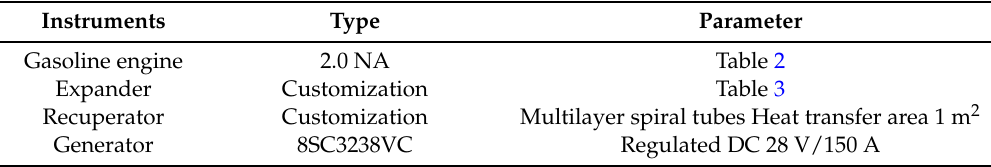
Table 1. Parameters for the main instruments of test system.